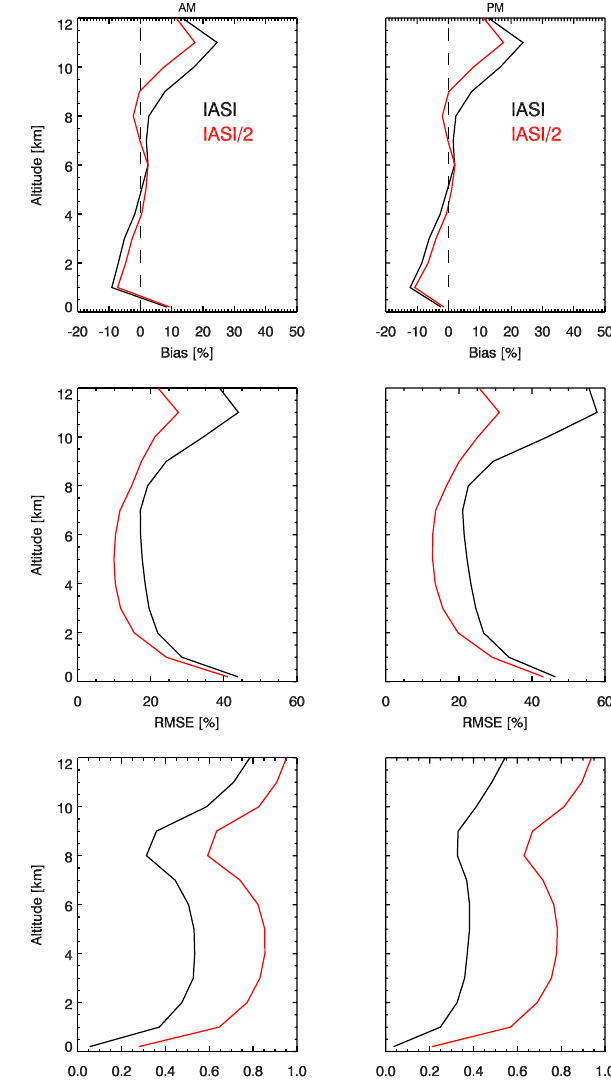
Fig. 6. Mean percent bias (top), percent RMSE (middle), Pearson coefficient (bottom) vertical profiles, AM (left) and PM (right), for IASI (black lines) and IASI/2 pseudo-observations (red lines). All quantities are calculated with the ensemble of simulations for Au- gust